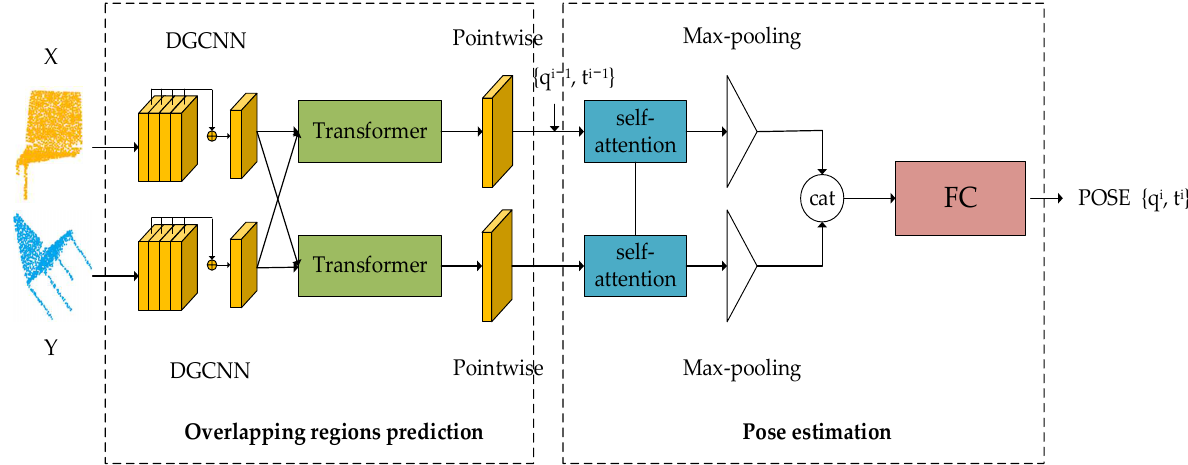
Figure 1. The overall pipeline of our network.